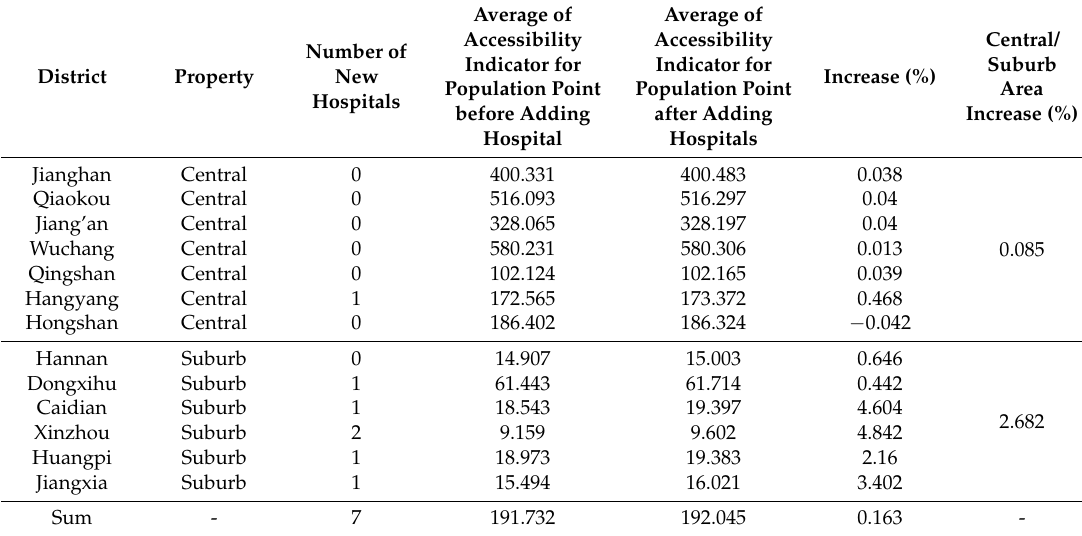
Table 9. Changes after the addition of new